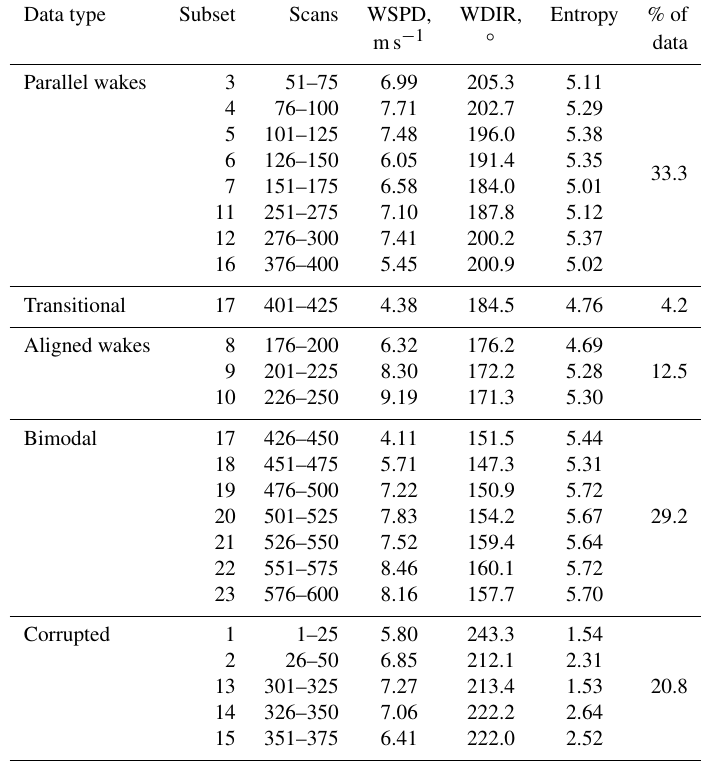
Figure 8. Sample averaged subsets and intensity histograms corresponding to the averaged subset and a single scan within the subset. The wind speed data are normalized to imitate the grayscale intensity. Despiking and removal of non-physical wind speeds are not performed to preserve the characteristics before preprocessing. Table 1. Overview of the lidar data